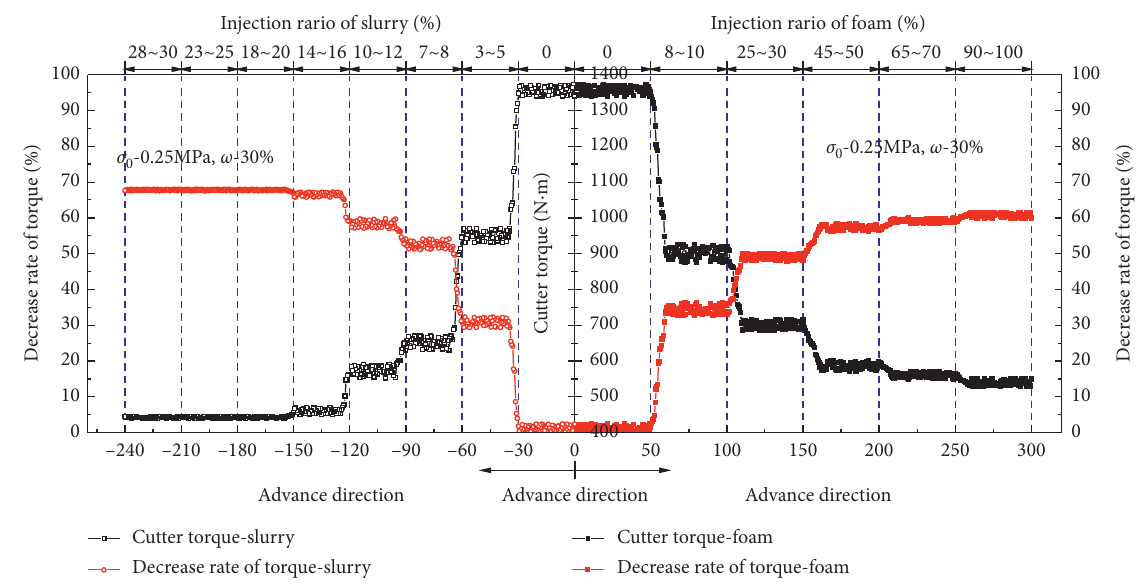
Figure 27: Effect of two types of soil conditioners on cutter torque at water content 30% and soil pressure